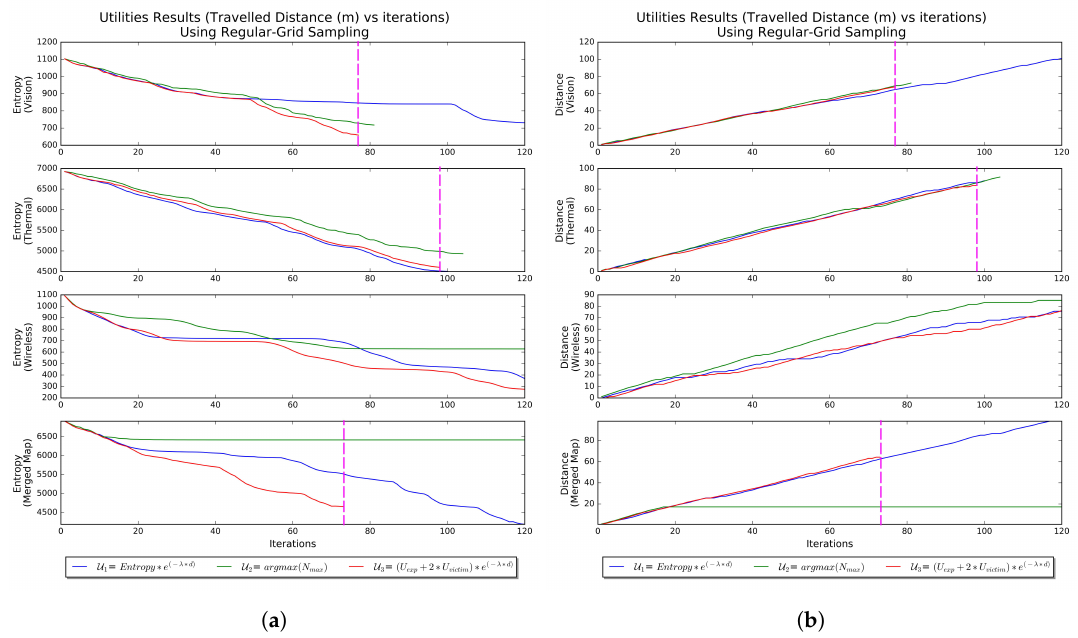
Figure 12. Regular Grid Sampling Approach Results. ( a ) Entropy vs. Iteration using Regular Grid Sampling Approach. The fastest method is indicated by the magenta vertical dash line. ( b ) Distance vs. Iteration using Regular Grid Sampling Approach. The fastest method is indicated by the magenta vertical dash line. Results of RGSA tests. VF: victim Found It: Iterations, D: Distance, TER: Total Entropy Reduction. The numbers in bold indicate better